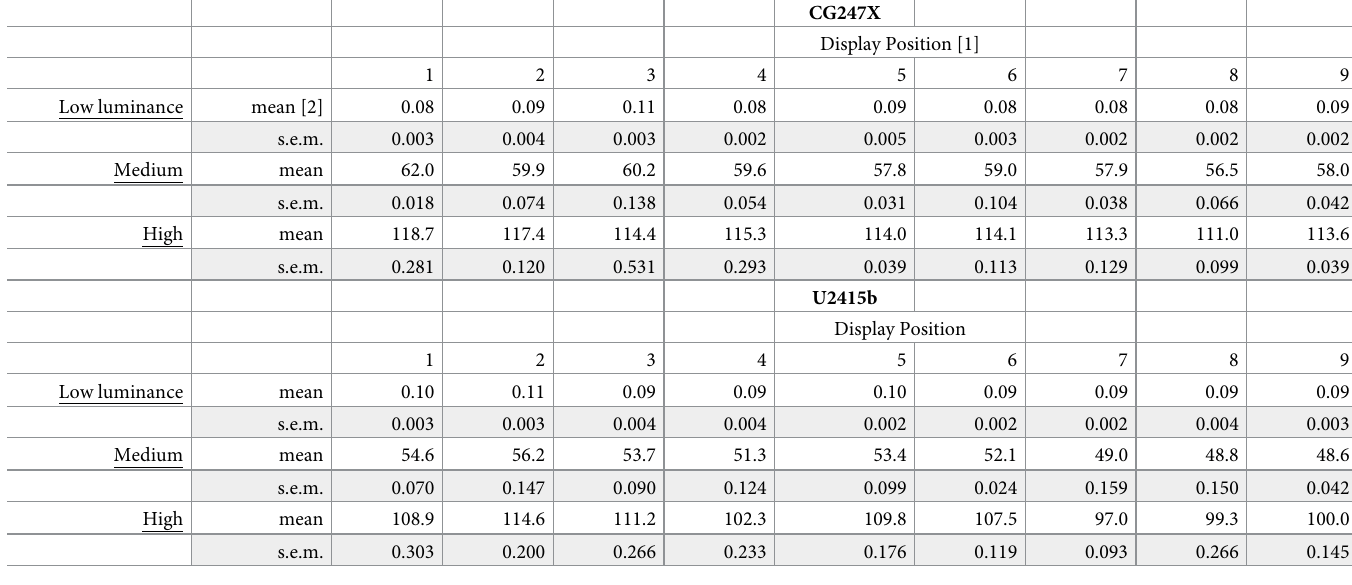
Table 1. Spatial uniformity of static test patches at low-, medium-, and high-luminance. Unit of measurement is cd/m 2 .